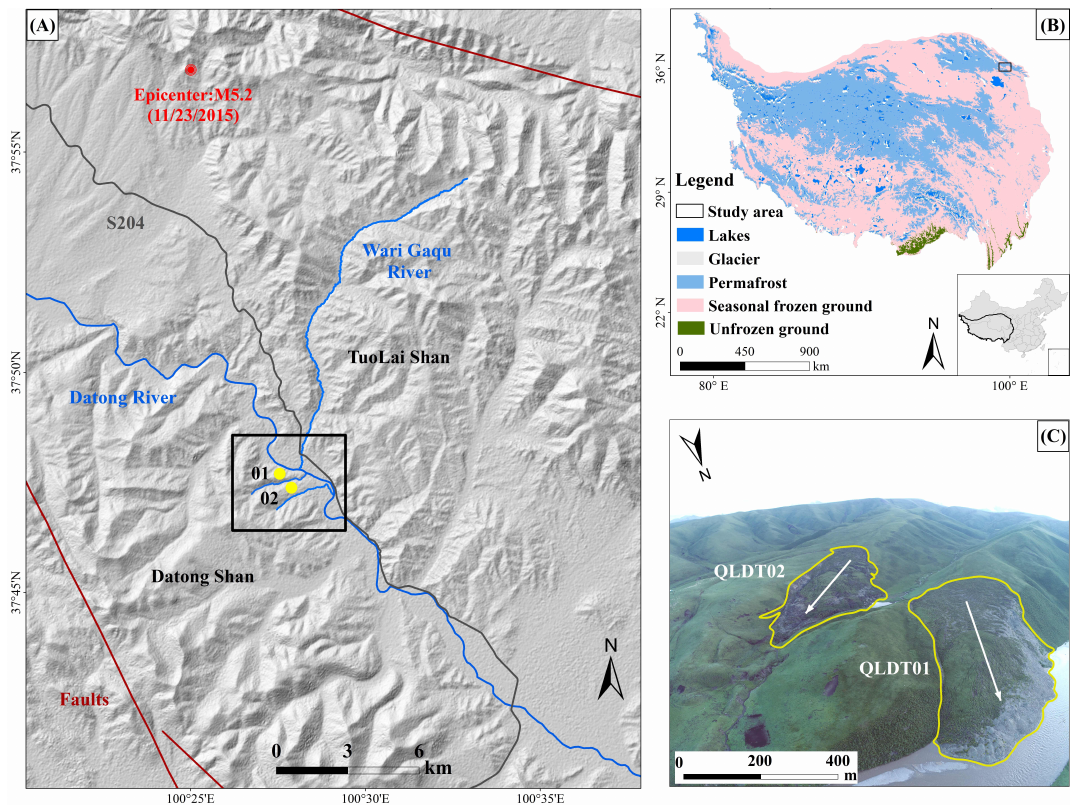
Figure 1. Study area and field photos. ( A ) The locations of the twin landslides (QLDT01 and QLDT02) are marked by yellow dots within the black rectangle. The background map is the hill-shaded DEM. The mountains, rivers, and roads in our study area are marked. ( B ) The distribution map of permafrost and seasonal frozen ground in the QTP [35]. The black rectangle presents the location of our study area. The inner map in the bottom right-hand corner shows the location of the QTP in China. ( C ) An unmanned aerial vehicle (UAV) photograph of the twin landslides taken in April 2021. The white arrow denotes the direction of the landslide movement. The yellow polygons are the boundaries of the twin